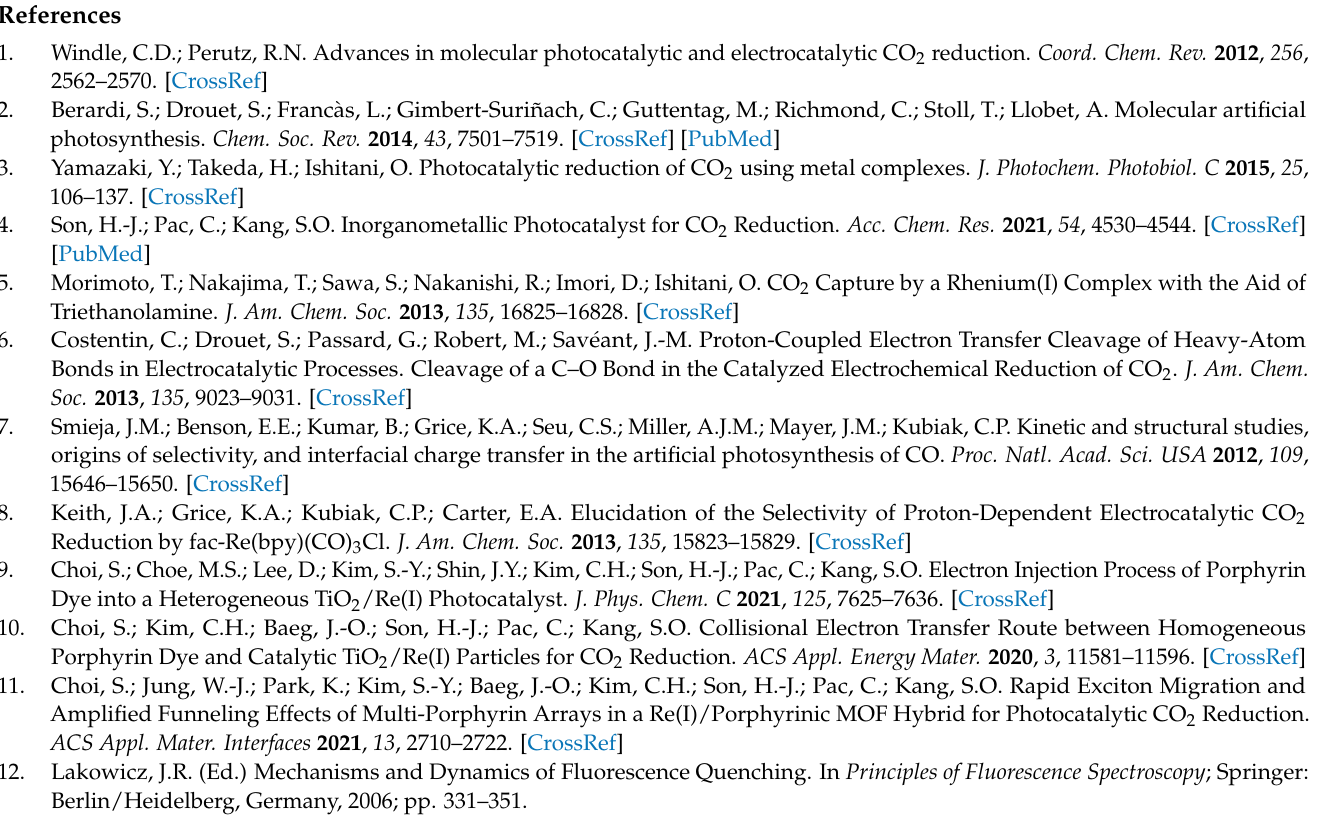
decay profiles; Figure S2: TA data for ZnPs + TiO 2 ; Table S1: Kinetic parameters from the global fits of ZnPs + TiO 2 ; Figure S3: Model populations obtained from the global